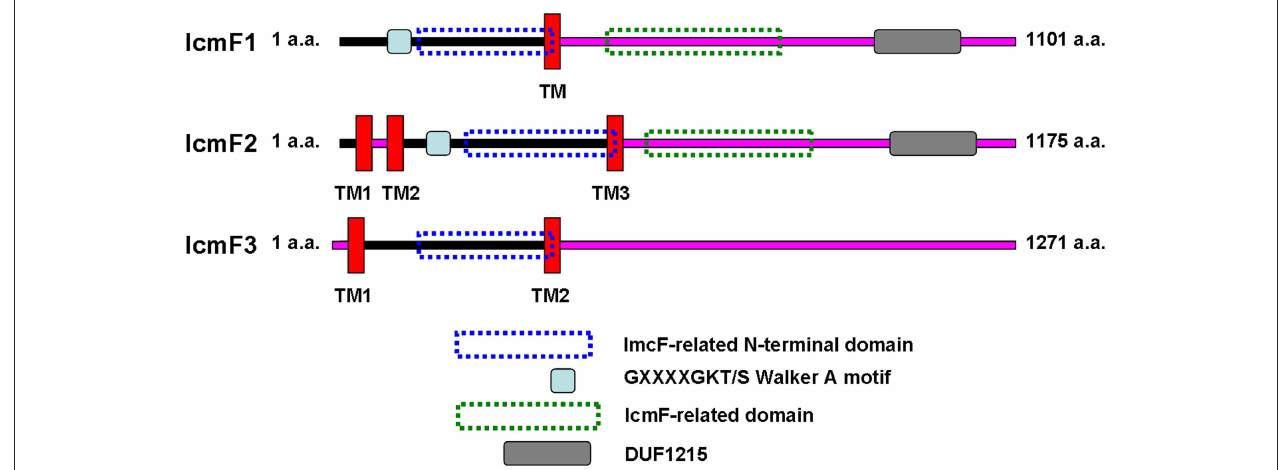
FIGURE 1 | Comparison of the predicted domain organization of IcmF1, IcmF2, and IcmF3 of P. aeruginosa PAO1. IcmF protein domain structures were analyzed using the software tools available at the ExPASY website (http://us.expasy.org/tools/). Transmembrane domains were analyzed with TMHMM (Krogh et al., 2001) prediction programs. InterProScan (Zdobnov and Apweiler, 2001) was used for the analysis of IcmF domain architecture. IcmF amino acids predicted to face the cytoplasmic side are indicated with a black line, and those facing the periplasm are indicated with a pink line.